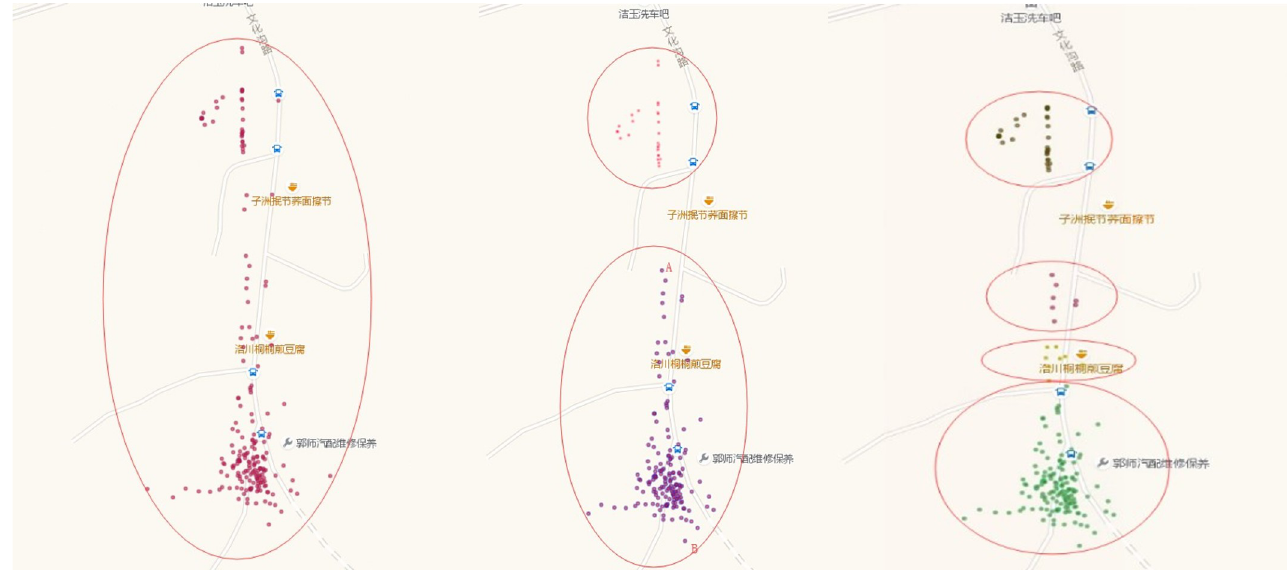
Fig 6. Clustering results of different performance indicators.